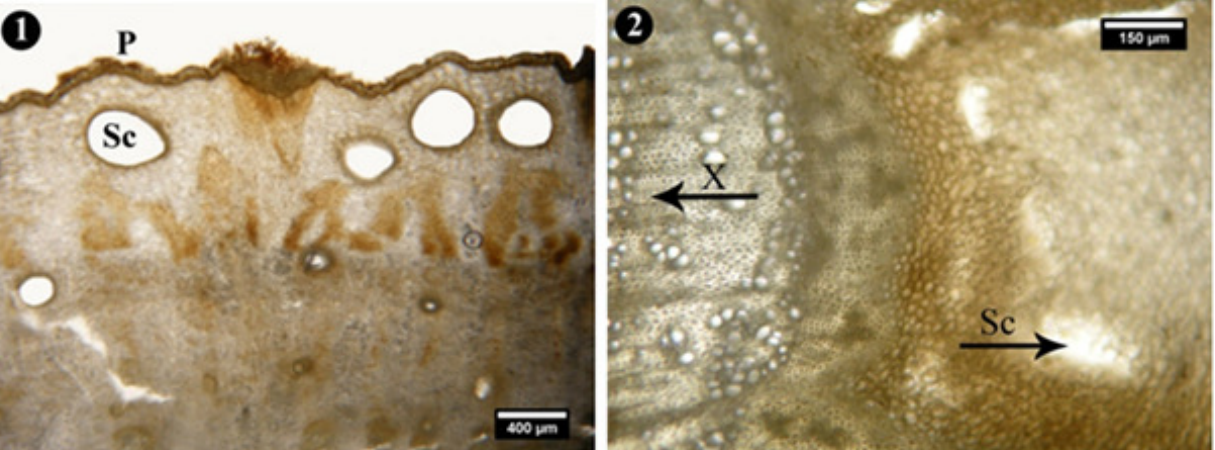
Fig.1.Cross-section of rhizome of Inula species. 1. I. helenium subsp. orgyalis , 2. I. ensifolia . P: periderm, Sc: secretory canals, X: xylem